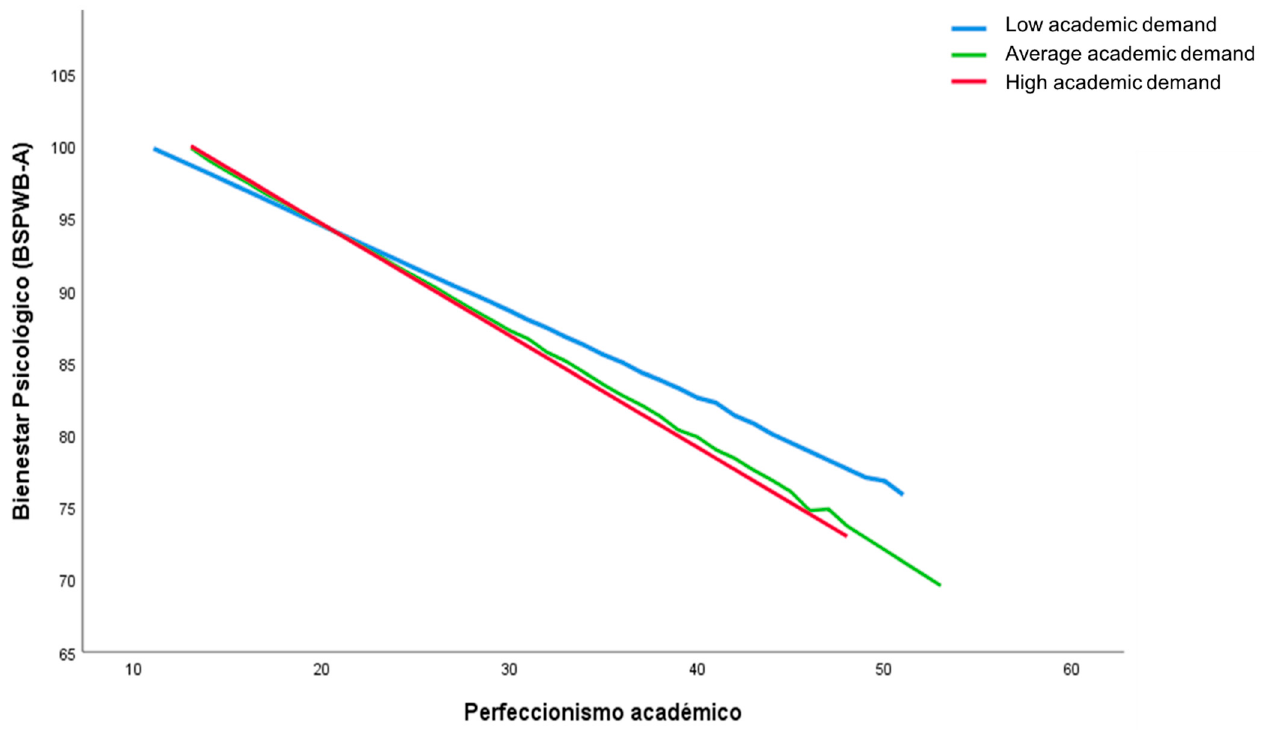
Figure 2. Level of academic demand of the degree as a mediator between the level of perfectionism and psychological well-being.